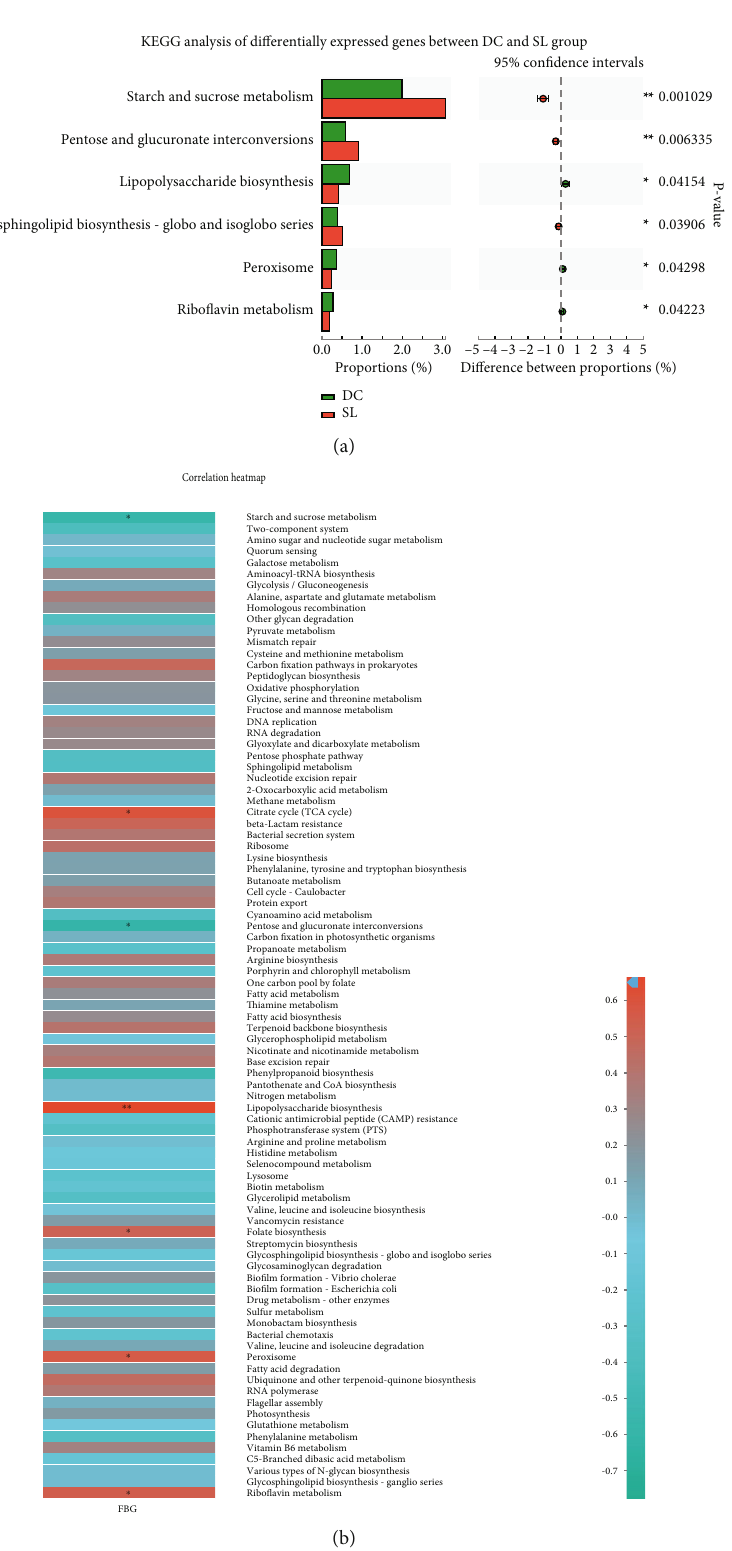
Figure 6: (a) KEGG analysis of di ff erentially expressed genes between DC and SL groups. ∗ P < 0 : 05 and ∗∗ P < 0 : 01 , compared with the DC group. (b) Correlation heatmap between KEGG analysis and FBG in db/db mice, the shades of color represent the richness of the function; correlation R values and P values were obtained by calculation; ∗ P < 0 : 05 and ∗∗ P < 0 : 01 ; R values were shown in di ff erent colors in the